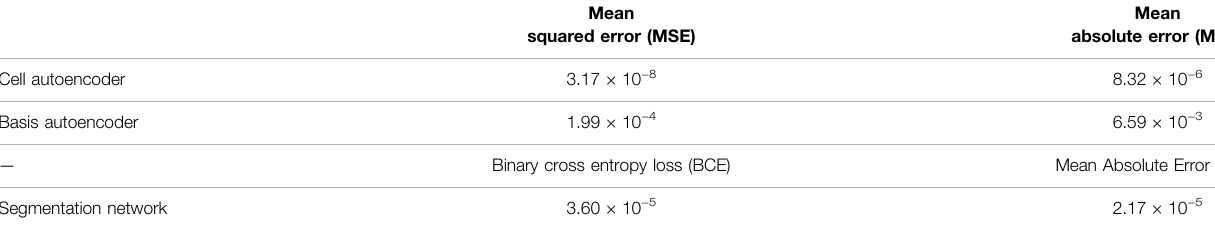
TABLE 2 | Test set errors in the cell and basis autoencoder and the segmentation network after training these models on the 2D materials dataset.